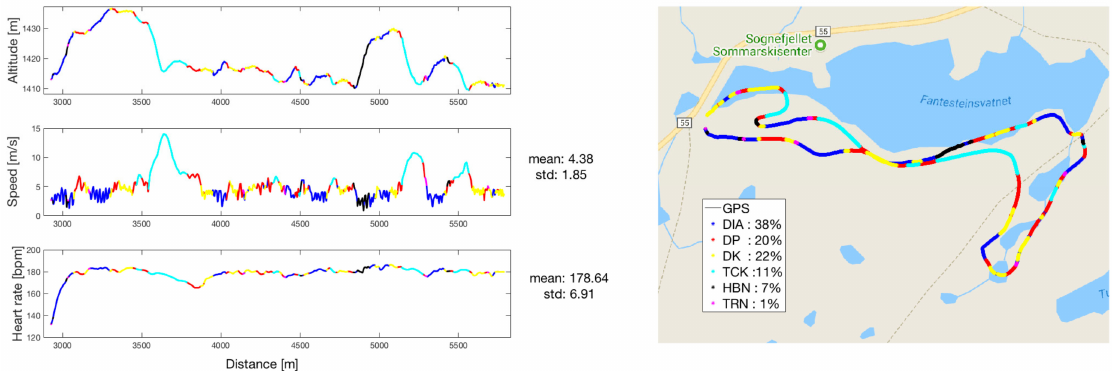
Figure A3. The dataset from subject 7 at Sognefjellet, the same as plotted in Figure A2, plotted as a GNSS trajectory (to the right) with subclasses indicated by color. The plots to the left display the height (altitude), speed and heart rate with sub-classes indicated by